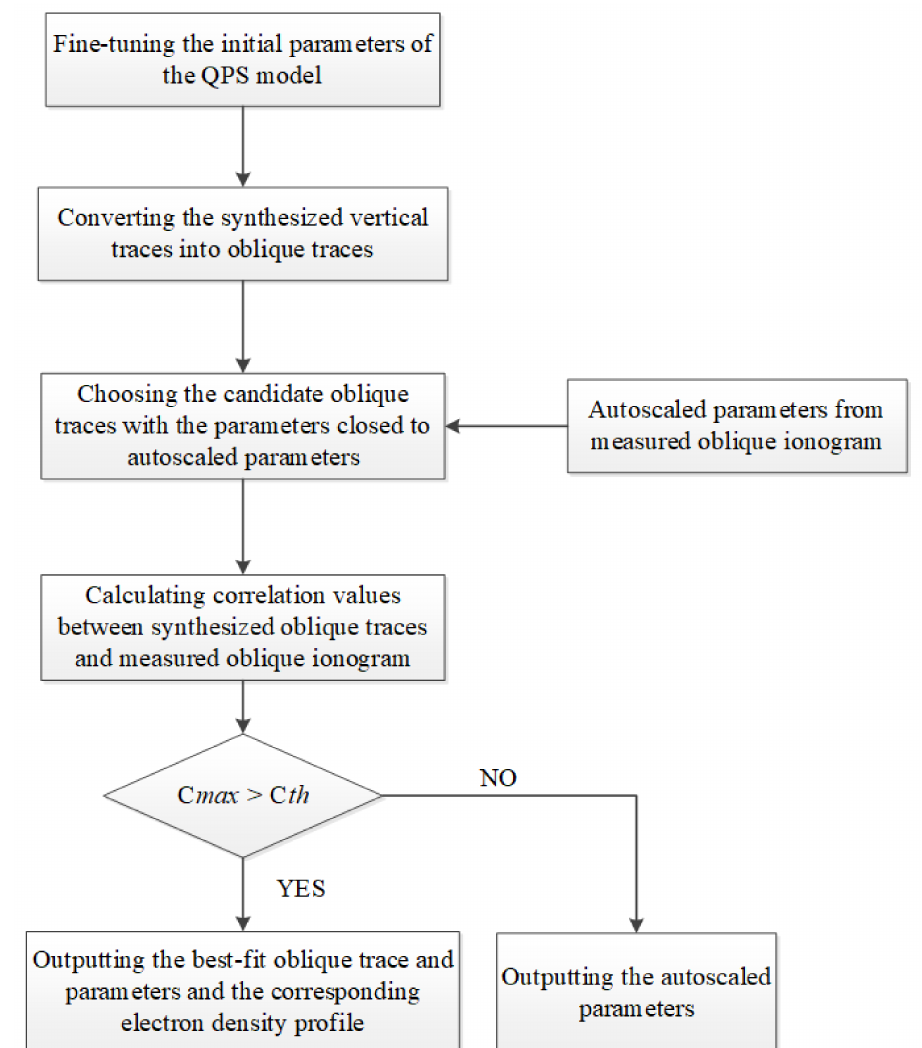
Figure 5. Flowchart of matching measured oblique ionograms with synthesized oblique